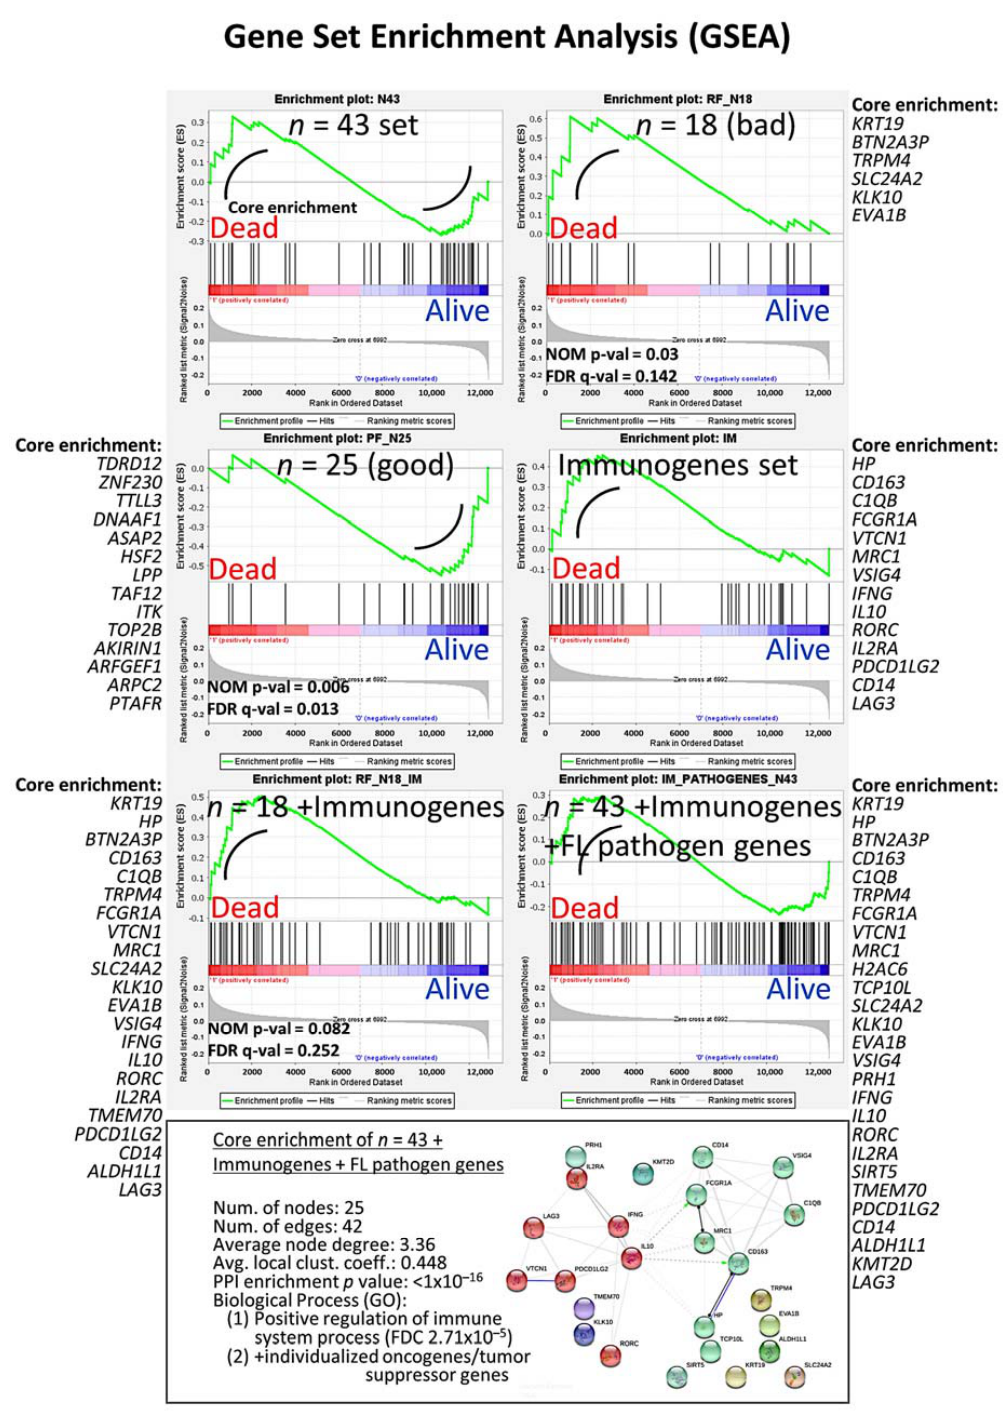
Figure 7. Gene set enrichment analysis (GSEA) was performed to confirm the results of the multivariate Cox regression for the overall survival analysis. The set of 43 were used in addition to genes of the immune response as well as oncogenes and tumor suppressor genes related to the pathogenesis of follicular lymphoma. The genes of the core enrichment are shown as well as a functional network association